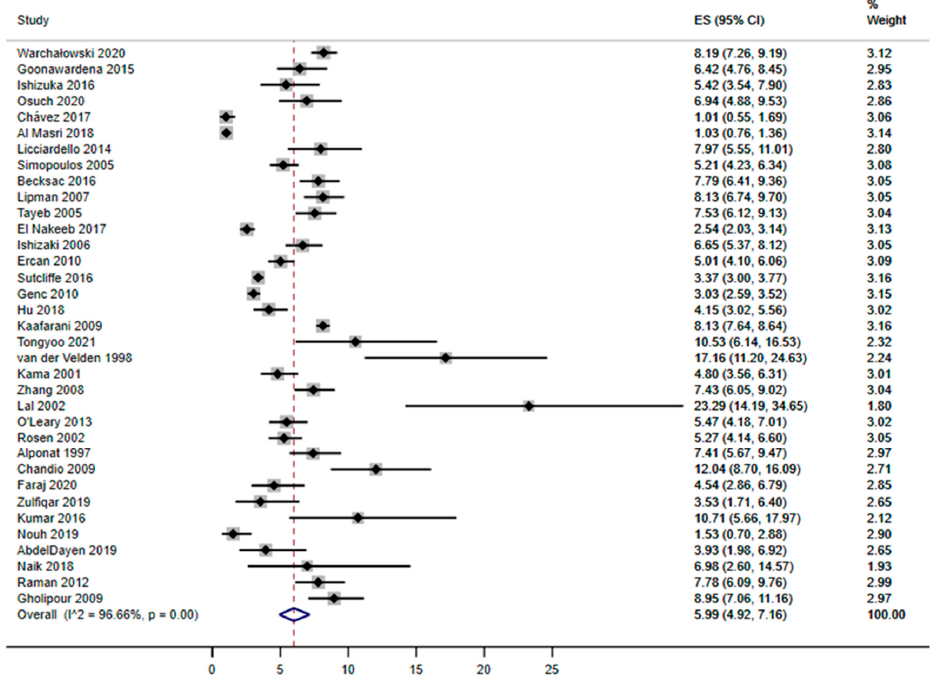
Figure 2. Forest plot of the pooled conversion rate [1–5,17,21–49]. The graph shows individual and pooled conversion rates (expressed in terms of percentage). 3.2. Risk Factors for conversion from Laparoscopy to Open Surgery during Cholecystectomy